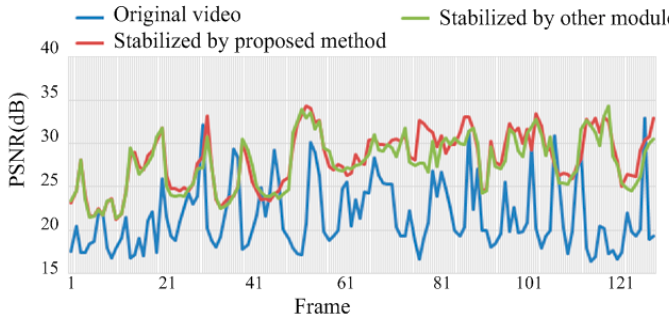
Figure 21. PSNR values illustrated for the original video (in Blue ) and the stabilized video (in Red ).